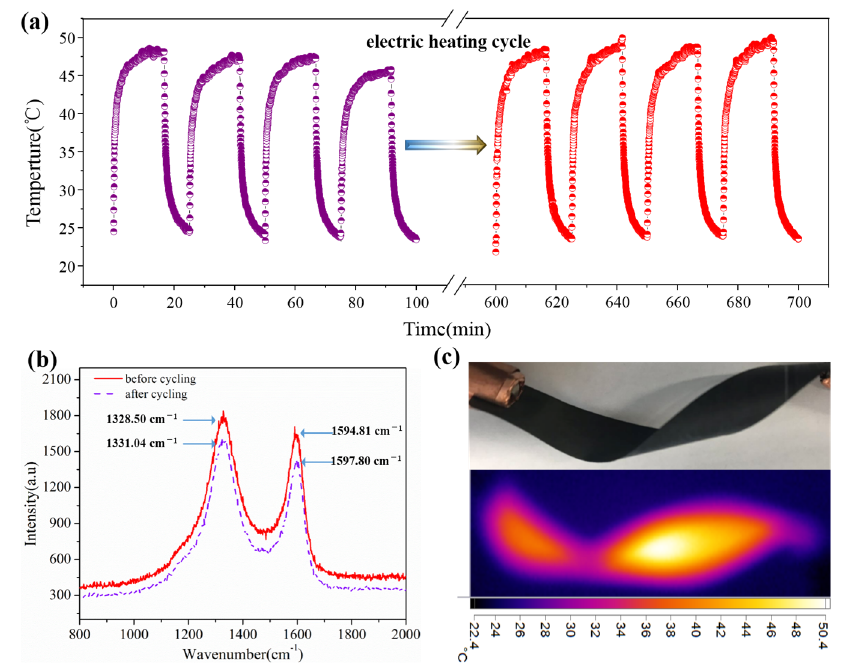
Figure 7. Electric-heating cycle performance of GO/CCNF film. ( a ) heating and cooling cycle; ( b ) Raman spectra; ( c ) flexibility. ( b ) Raman spectra; ( c )